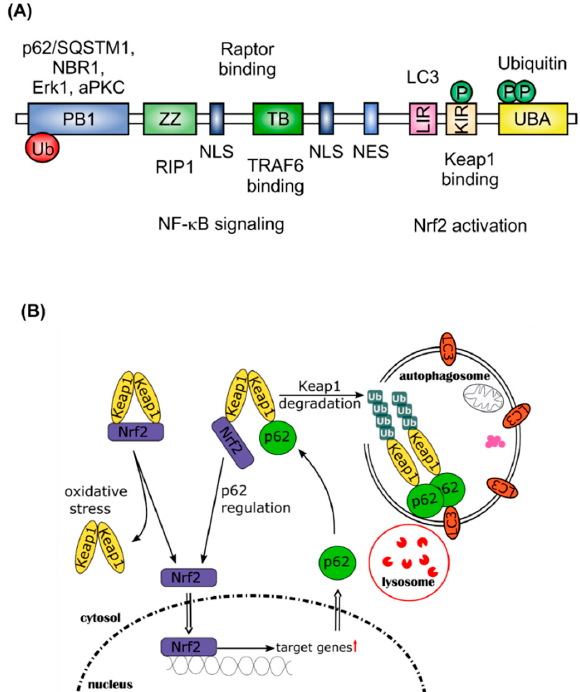
Figure 2. Positive feedback-loop of Nrf2 activation by p62/SQSTM1 . ( A ) Domain structure of p62/SQSTM1; ( B ) p62/SQSTM1 is an important protein for selective autophagy, binds to Keap1 and